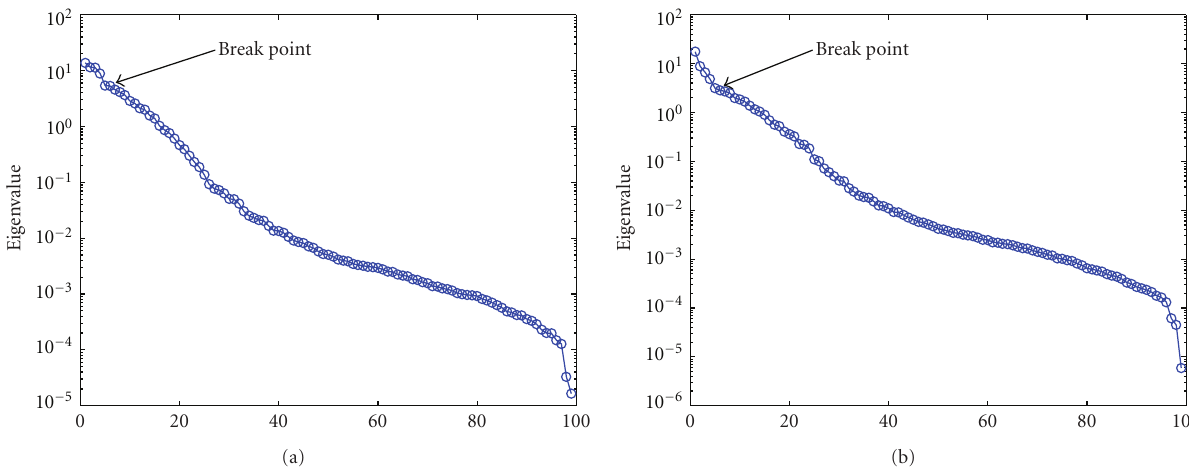
Figure 7: Eigenvalues of the multistatic response matrix of subsurface imaging targets: (a) on the scattered data without migration; (b) on the scattered data after